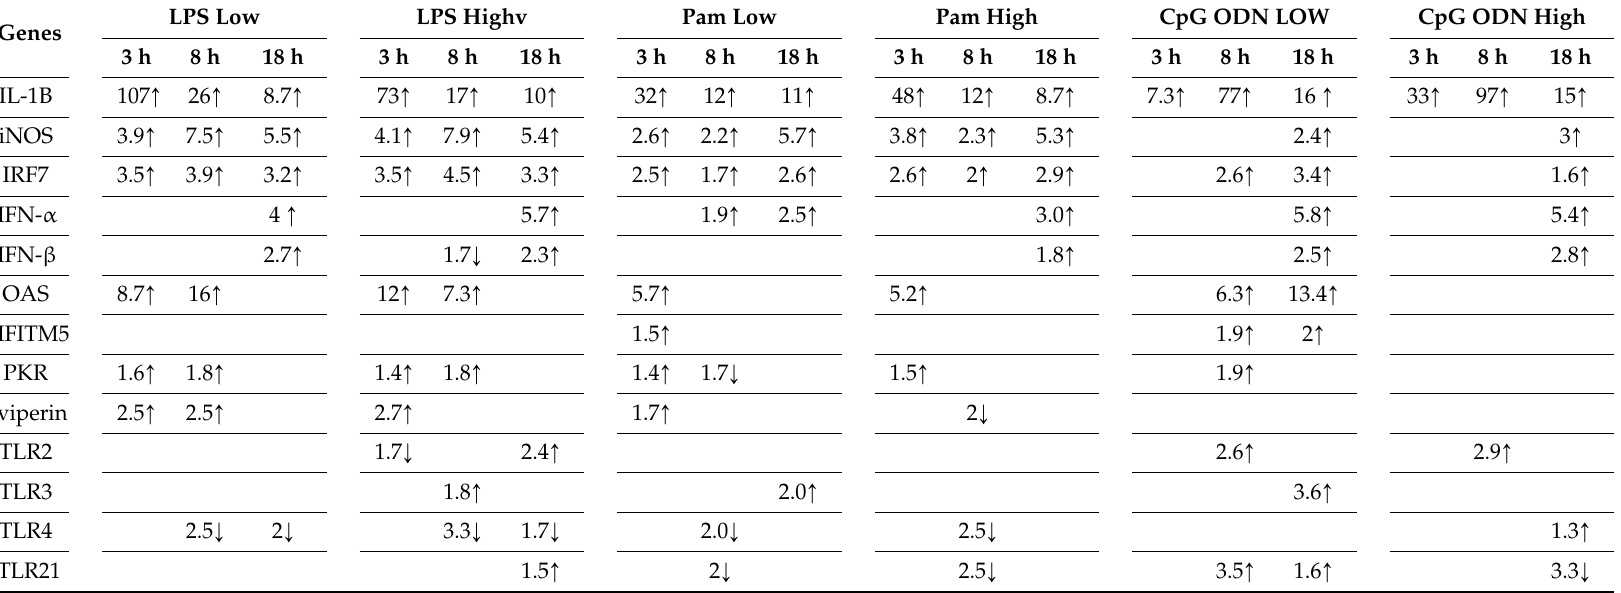
Table 1. Cytokine gene expression of chicken TOC stimulated with Pam3CSK4 (1.0 µ g/mL (Pam3 low) and 10 µ g/mL (Pam3 high)), LPS from E. coli